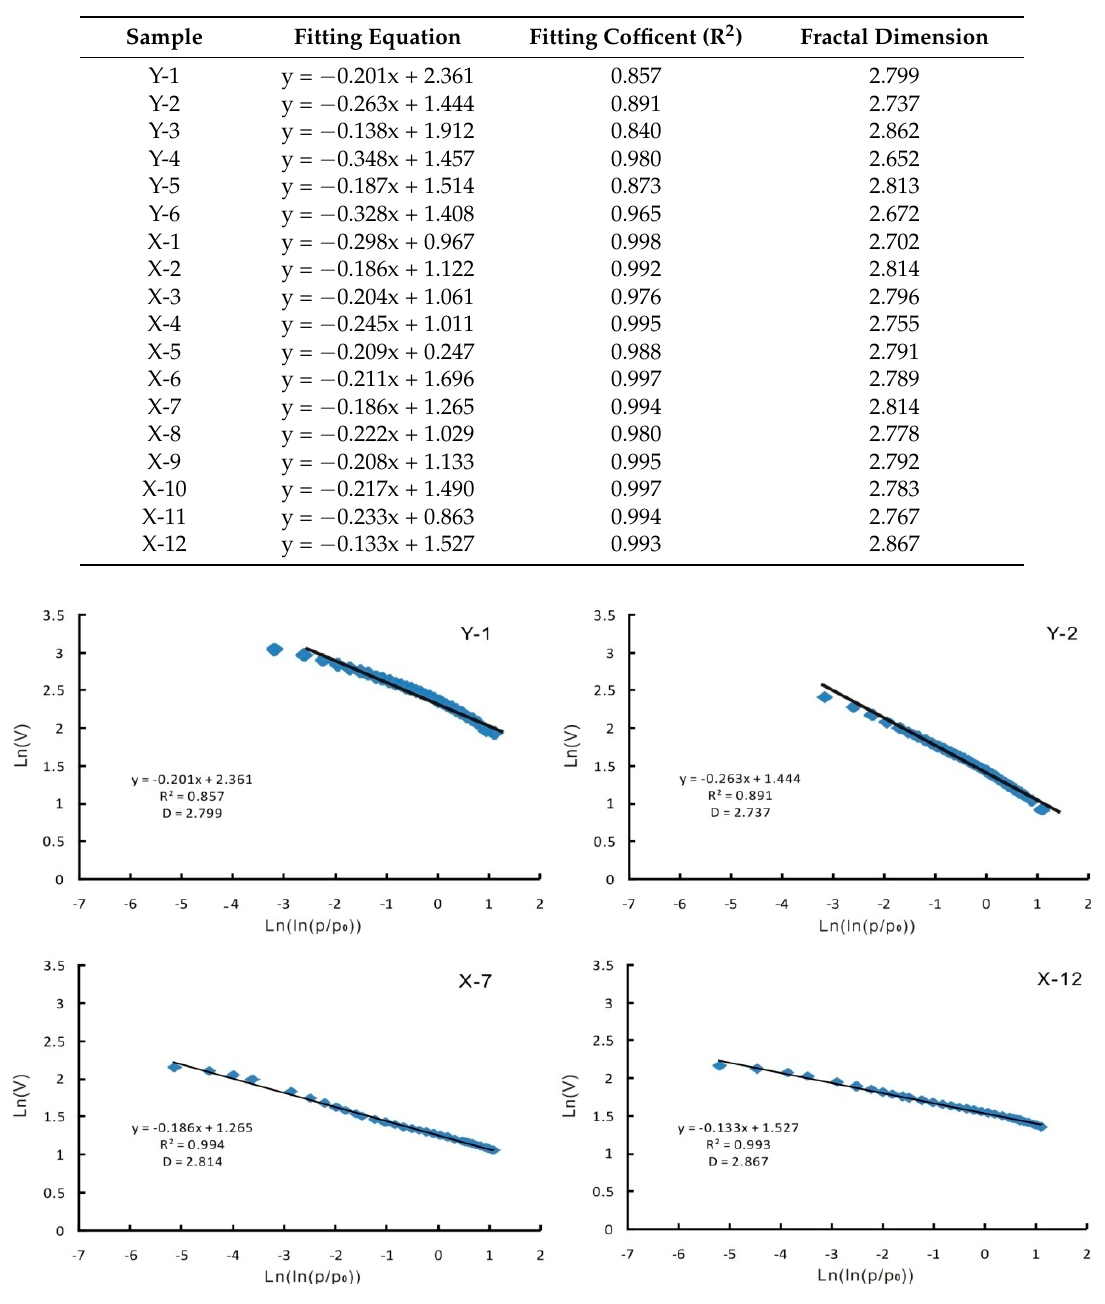
Table 5. Fractal dimension of transitional Longtan Shale samples from YV-1 and XD-1.